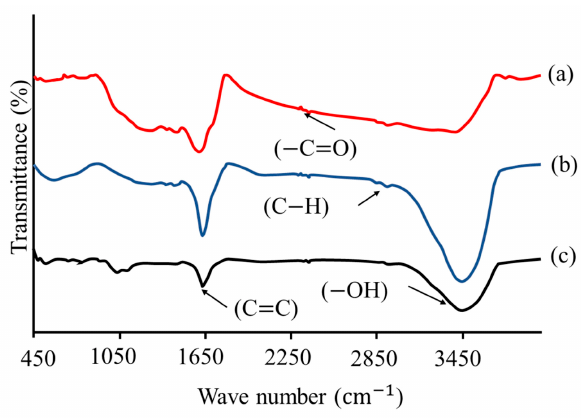
Figure 7. FTIR spectra of ( a ) wet coal exposed to CO 2 at 300K and pressure up to 6 MPa, ( b ) dry coal exposed to CO 2 at 300 K, and ( c ) fresh coal. Modified from [92]. The Raman method allows the analysis of microcrystalline carbon structure [127] based on signal related to the vibrations of aromatic fused rings [129]. This technique can be used to study gas adsorption coal by evaluating the D peak (1332 to 1366 cm − 1 ) and G peak (1576 to 1608 cm − 1 ) [127].